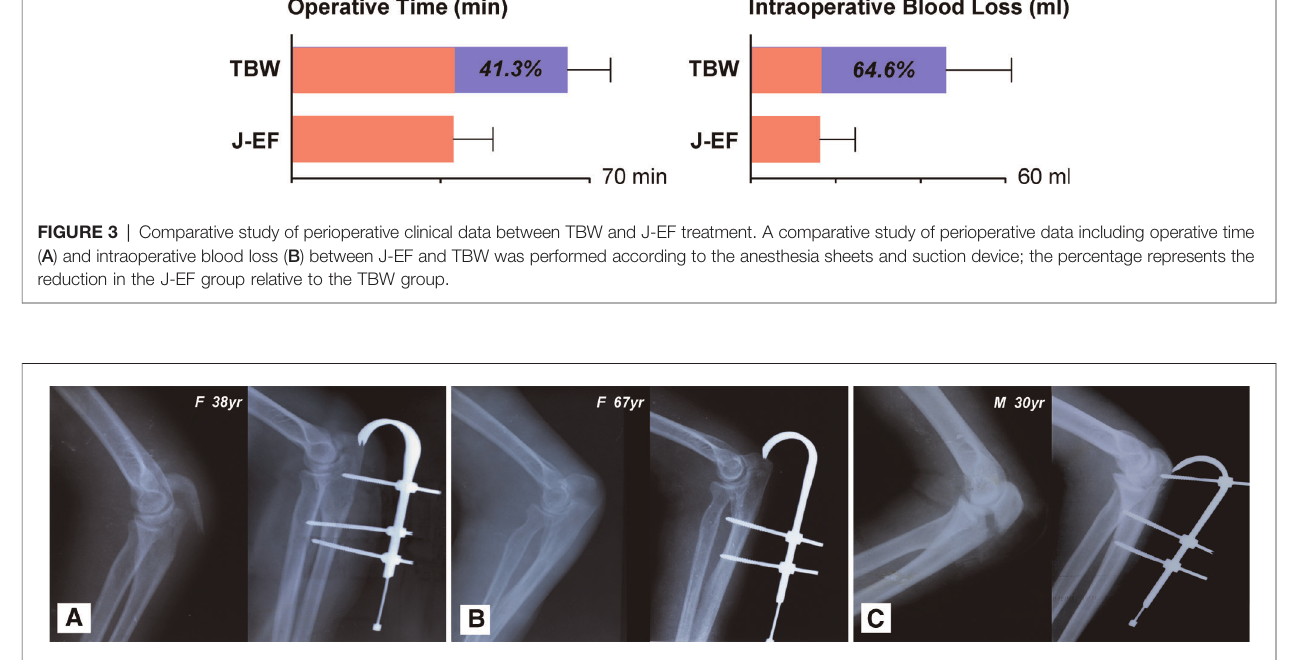
FIGURE 4 | Preoperative and postoperative X-rays of the elbow joint. Typical cases treatment with J-EF in our study. ( A ) Female patient of 38 years, car accident; ( B ) female patient of 67 years, fall from height; and ( C ) male patient of 30 years, sports injury.